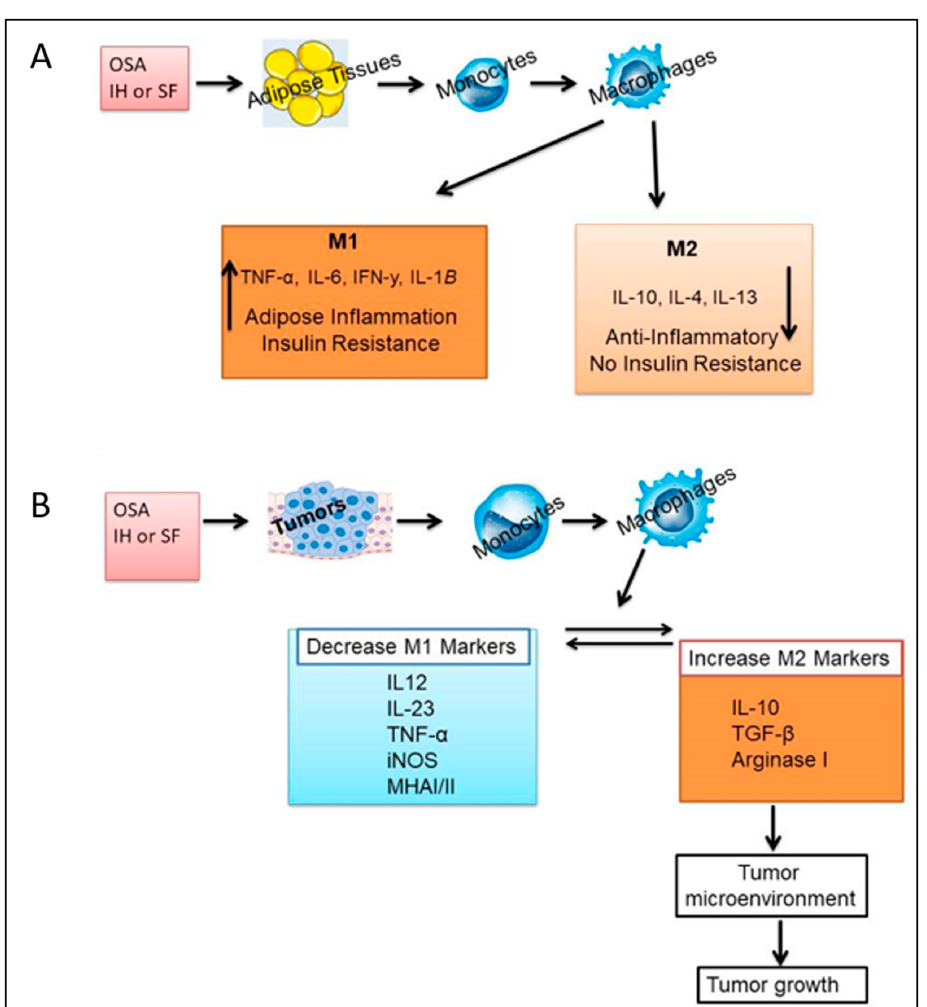
Figure 2. Effects of OSA on macrophages derived from adipose tissues and tumors. Tissue macrophages are composed of different subpopulations exerting different physiological properties. The two well-known subtypes are: M1 (classically activated macrophages) with pro-inflammatory